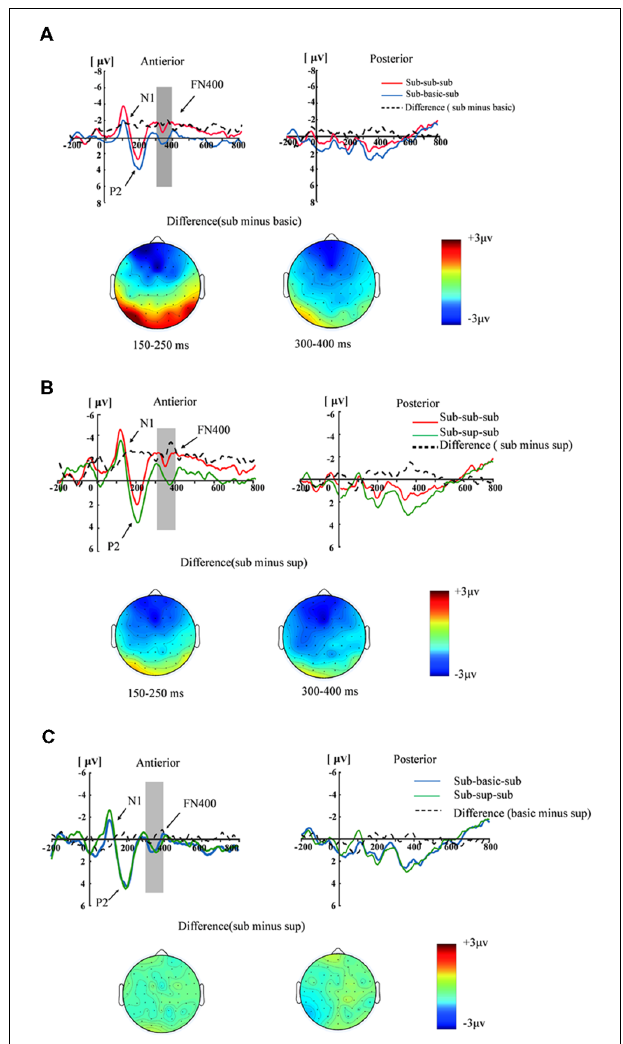
FIGURE 3 | Grand-average event-related potential (ERP) waveforms measured at the anterior [(F3+F1+Fz+F2+F4+FC3+FC1+FCz+FC2+FC4)/10] and posterior [(CP3+CP1+CPZ+CP2+CP4+P3+P1+Pz+P2+P4)/10] regions for the subordinate masking, basic masking and subordinate-superordinate-subordinate. (A) The grand-averaged waveforms elicited by subordinate masking stimulus and basic masking stimulus and the difference waveforms (subordinate minus basic) in the anterior and posterior regions, as well as the topographies of the difference waveforms at 150–250 ms and 300–400 ms. (B) Grand-averaged waveforms elicited by subordinate masking stimulus and superordinate masking stimulus and the difference waveforms (subordinate minus superordinate) in the anterior and posterior regions, as well as the topographies of the difference waveforms at 150–250 ms and 300–400 ms. (C) Grand-averaged waveforms elicited by basic masking stimulus and superordinate masking stimulus and the